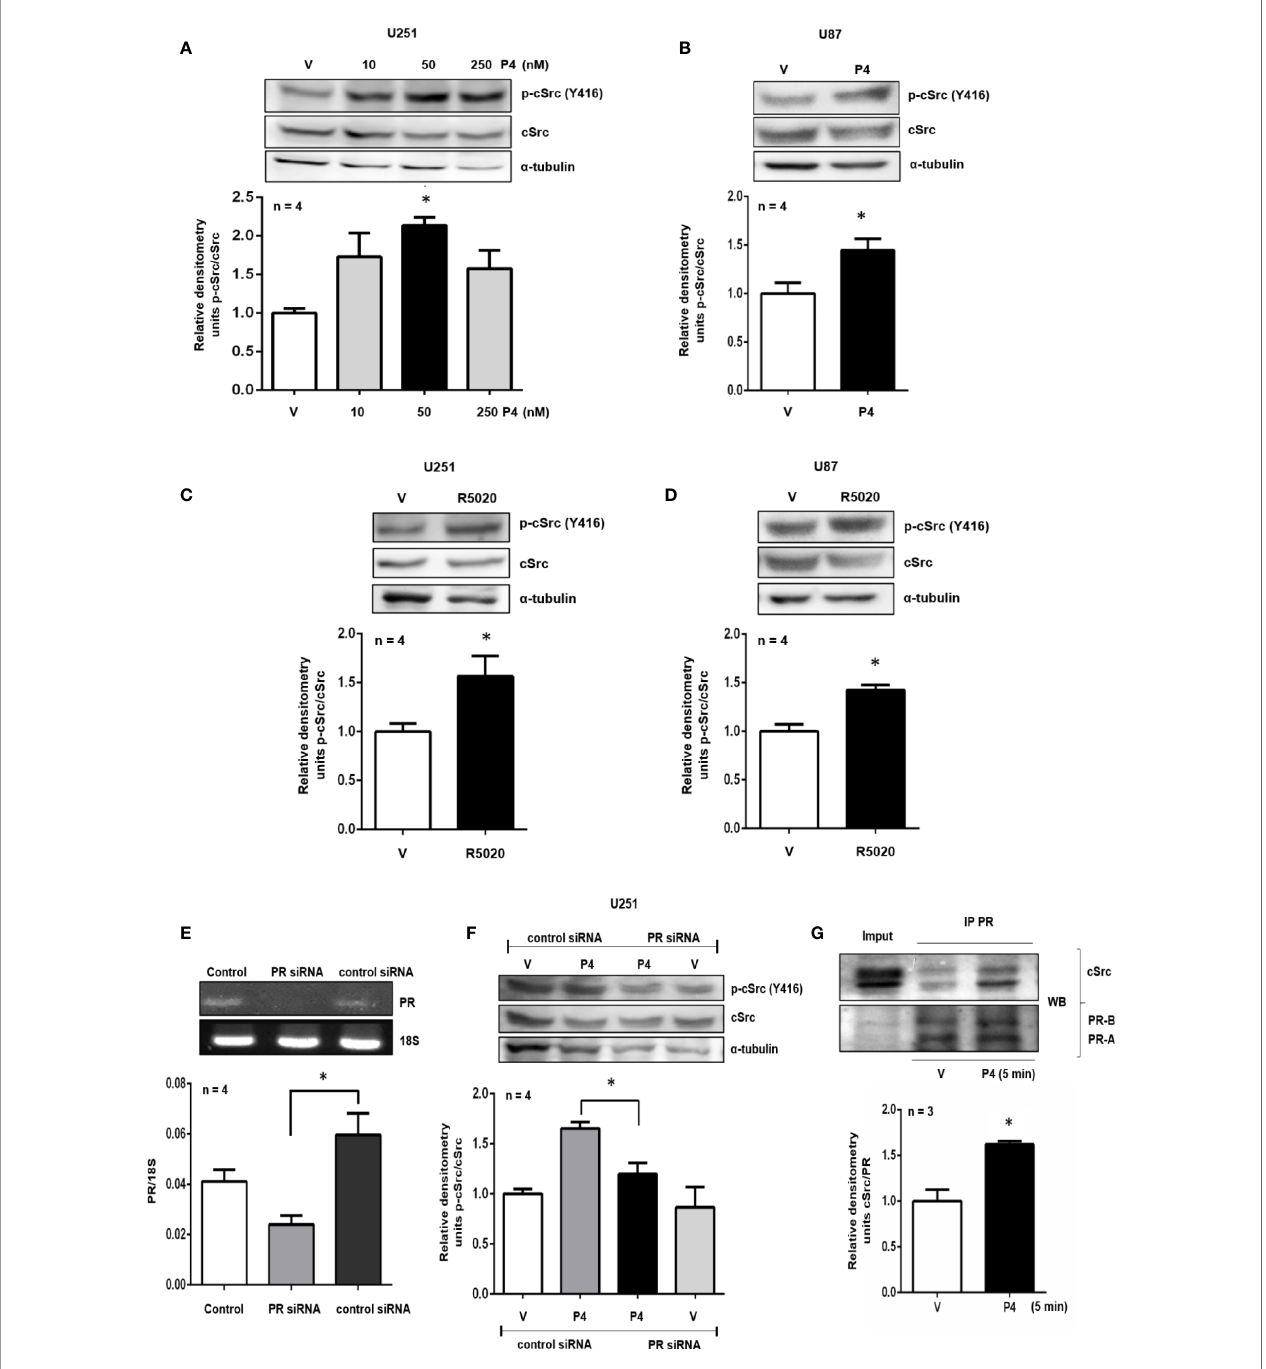
FIGURE 1 | P4 induces the activation of cSrc through PR. (A, B) U251 and U87 cells were treated with P4 (10, 50 and 250 nM) and P4 (50 nM) respectively or vehicle (V, DMSO 0.01%) for 10 min. (C, D) U251 and U87 cells were treated with R5020 (10 nM) or vehicle (V, DMSO 0.01%) for 10 min. (E) U251 cells were transfected with PR siRNA and a control siRNA (an aleatory RNA sequence) (100 nM) or were only treated with lipofectamine (Control). (F) Transfected cells with PR siRNA or control siRNA were treated with P4 (50 nM) or vehicle (V, DMSO 0.01%) for 10 min. Upper panels show the representative western blots for p-cSrc, cSrc, and a -tubulin or representative RT-PCR bands for PR and 18S mRNA. Lower panels show the densitometric analysis. (G) U251 cells were treated with P4 (50 nM) or vehicle (V, DMSO 0.01%) for 5 min and co-immunoprecipitated with PR. Data were normalized respect to the vehicle or control. Results are expressed as the mean ± S.E.M. (A – F) n = 4 (G) n = 3; *p <